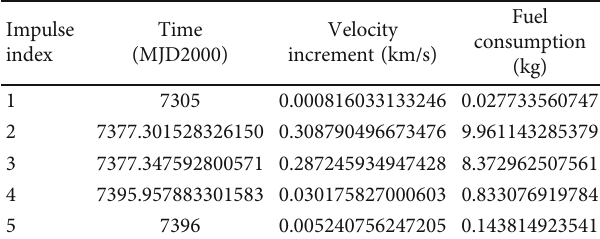
Table 7. Figure 17 shows the design process of the transfer of each satellite.